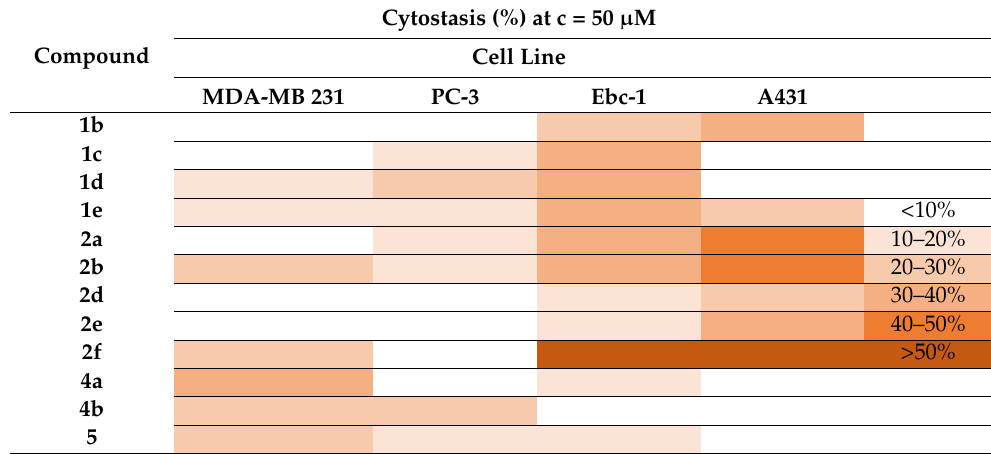
Table 1. In vitro cytostatic effect of α -aminophosphonic derivatives on human tumor cell lines.